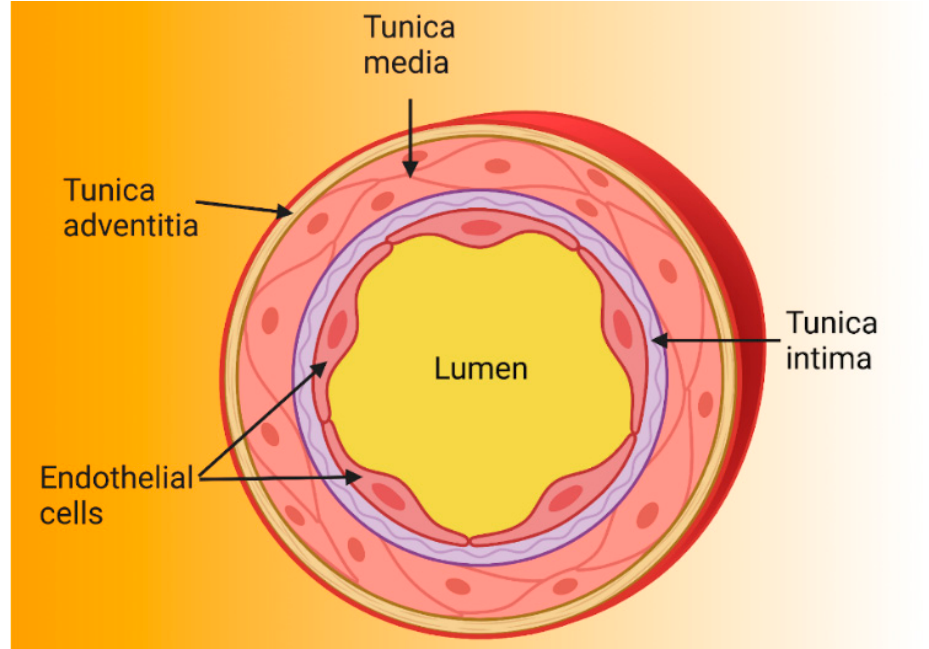
Figure 1. Structure of the arterial wall. Because arteries are supplying blood to tissues and are exposed to high pressure, their walls are thicker than those of other blood vessels. Arterial walls are composed of three layers: the tunica intima is the innermost layer and is made up of endothelial cells anchored to the basal lamina (connective tissue); the tunica media contains vascular smooth muscle cells and regulates vascular tone; and the tunica adventitia is the outermost and contains nerve endings, perivascular adipose tissue, and connective tissue [27–29].